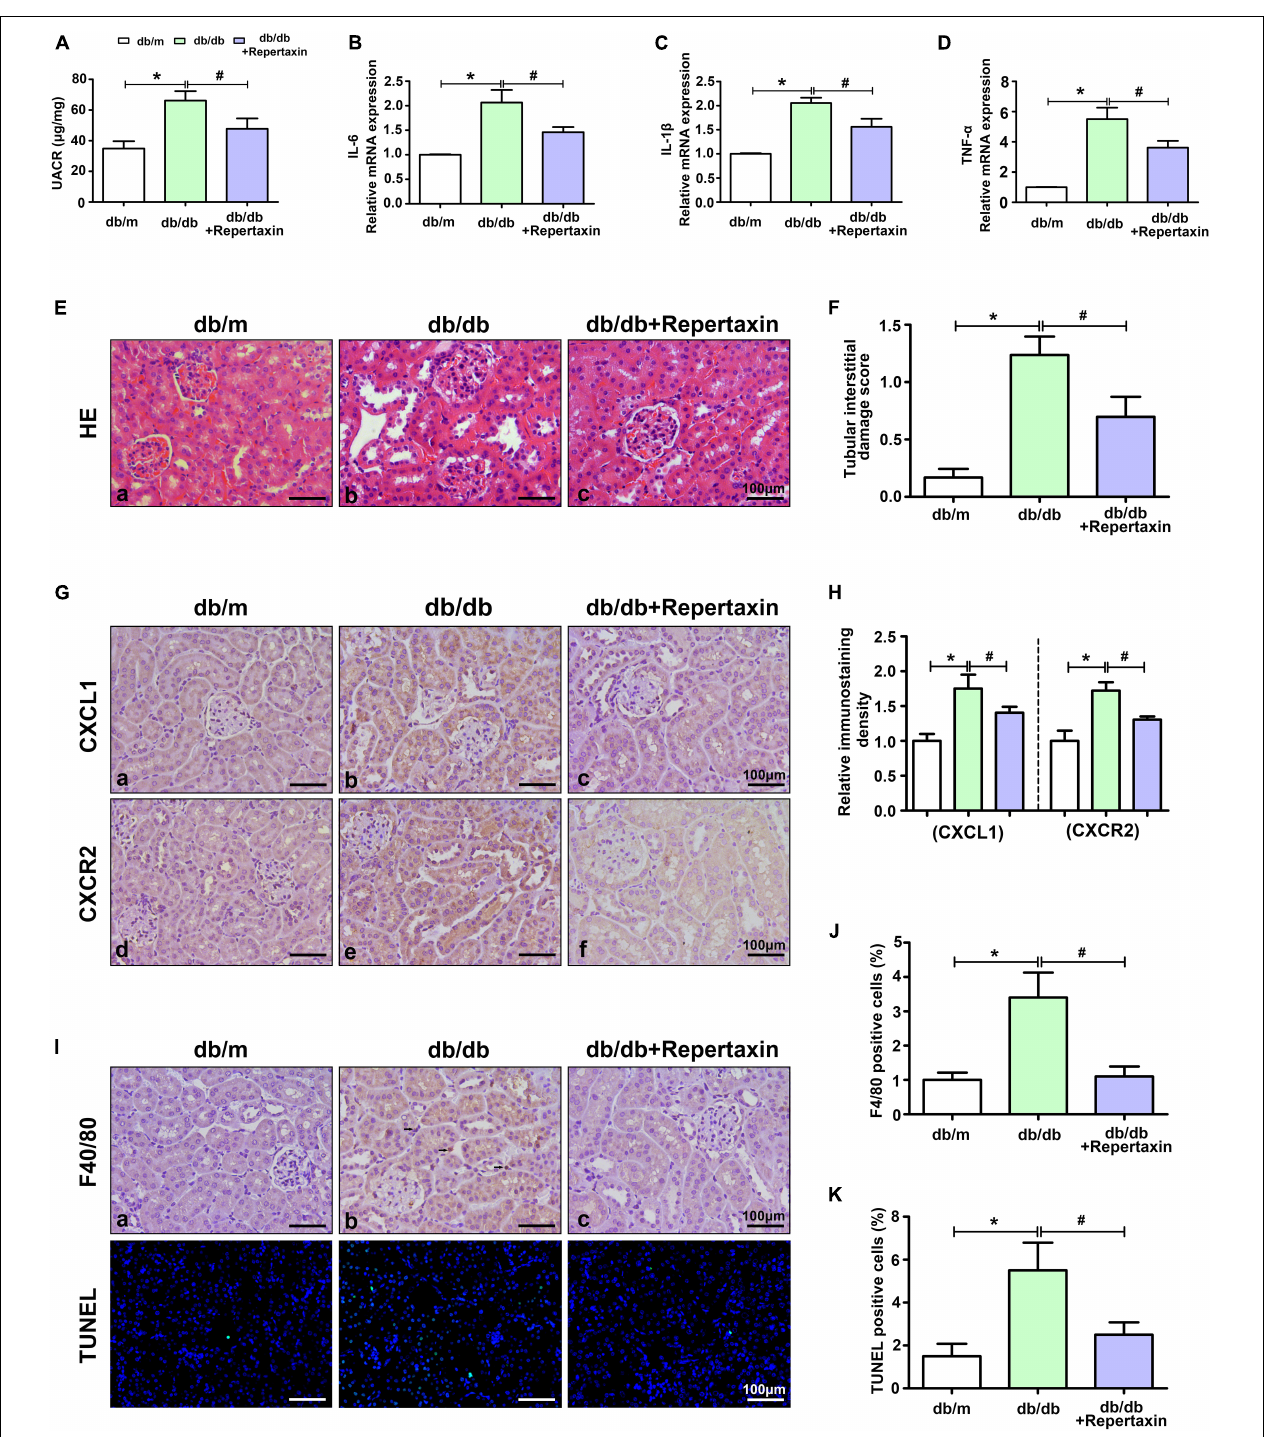
FIGURE 3 | Inhibition of CXCL1/CXCR2 axis activity alleviates renal inflammation and pathological damage. UACR levels (A) and the mRNA levels of IL-6 (B) , IL-1 β (C) and TNF- α (D) in mouse kidneys. (E) HE staining to detect pathological changes in the kidneys of mice. (F) The degree of tubular injury was assessed by the tubular interstitial damage score. (G) IHC staining was used to detect CXCL1 and CXCR2 expression in kidneys in different groups. (H) Histogram representing the levels of CXCL1 and CXCR2. (I) F4/80 staining was used to detect inflammatory cell infiltration, and apoptotic cells were detected by TUNEL staining. Histogram representing Inflammatory cell levels (J) and apoptotic cell levels (K) . Scale bar = 100 µ m. The values are the mean ± SD. n = 6/group. * p < 0.05 compared with the control group; # p < 0.05 compared with the db/db mice.